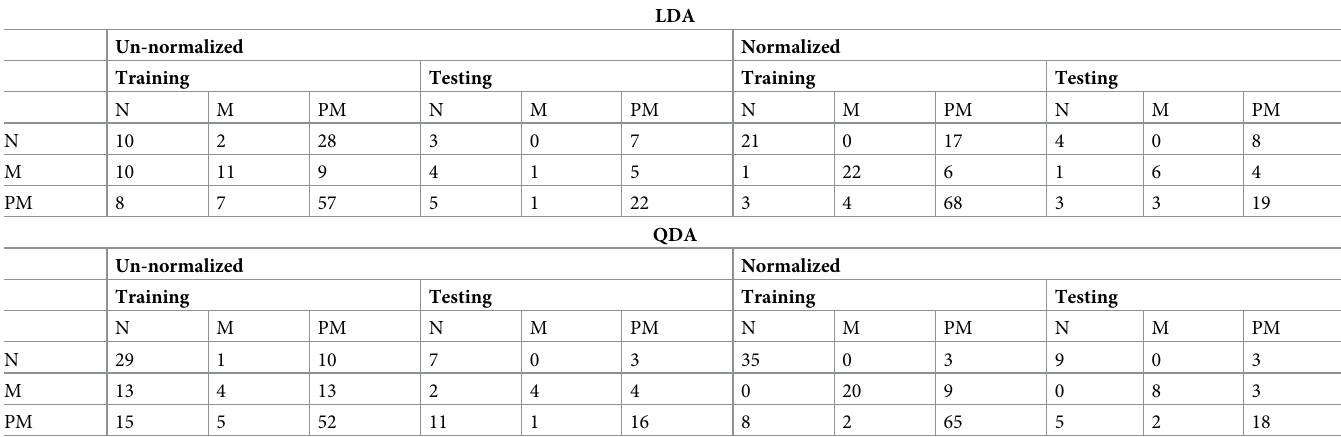
Table 5. Confusion table of LDA and QDA for buccal mucosa.